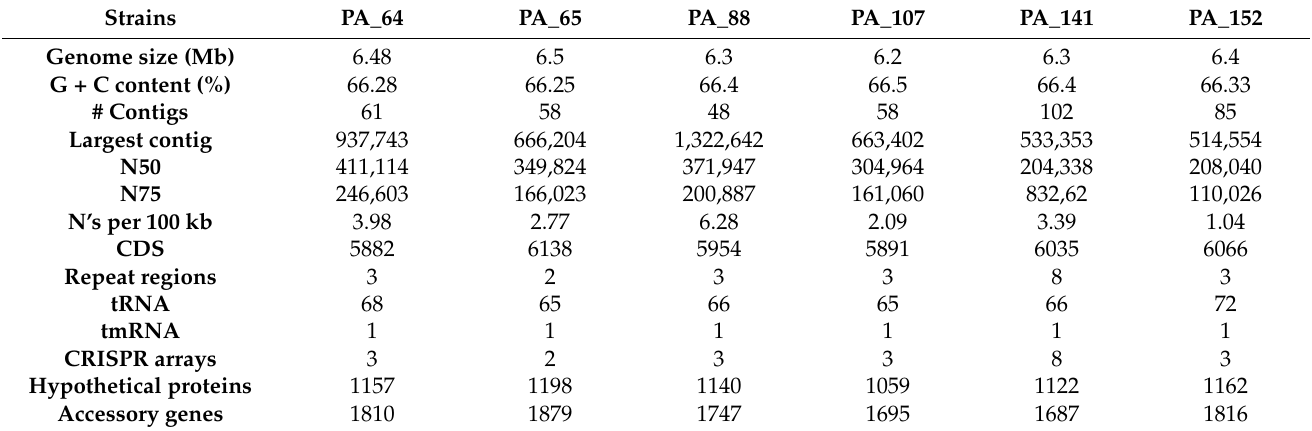
Table 2. Genomic features and statistics of new sequence type P. aeruginosa strains.